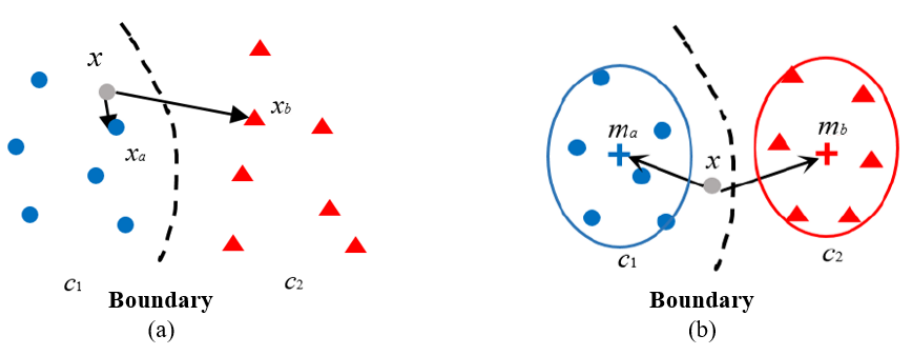
Figure 4. The second modification of DSA. ( a ) specific case. ( b )